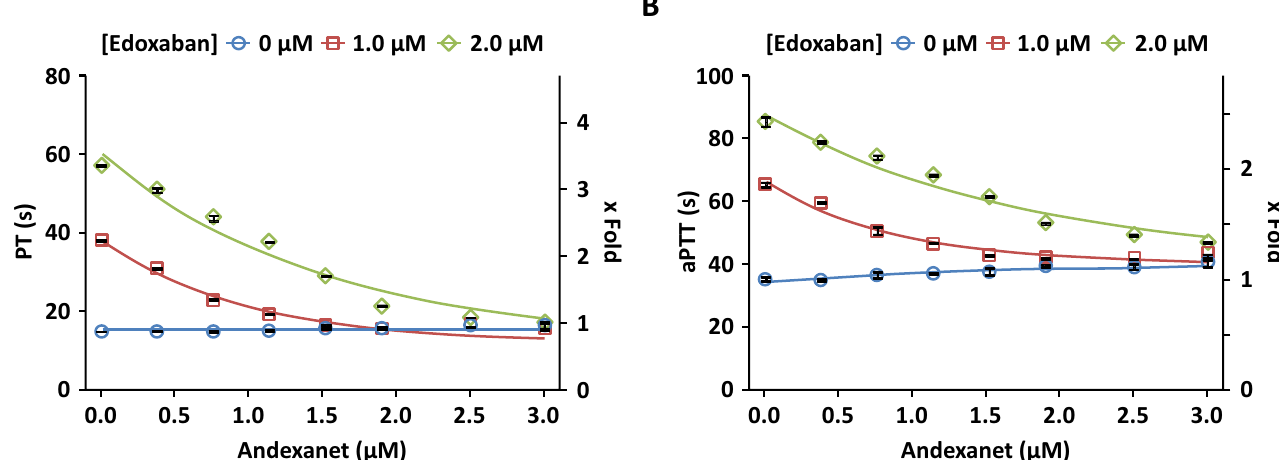
Fig 3. In vitro reversal of edoxaban-induced prolongation of PT and aPTT in human plasma. Plasma samples contained edoxaban at 0 ( (cid:14) ), 1.0 ( □ ), and 2.0 μM ( (cid:5) ) and increasing concentrations of andexanet (0, 0.38, 0.76, 1.14, 1.52, 1.9, 2.5, and 3.0 μM). PT and aPTT were measured on Stago Compact as described in Materials and Methods. Data were plotted as the mean ± standard deviation from two separate